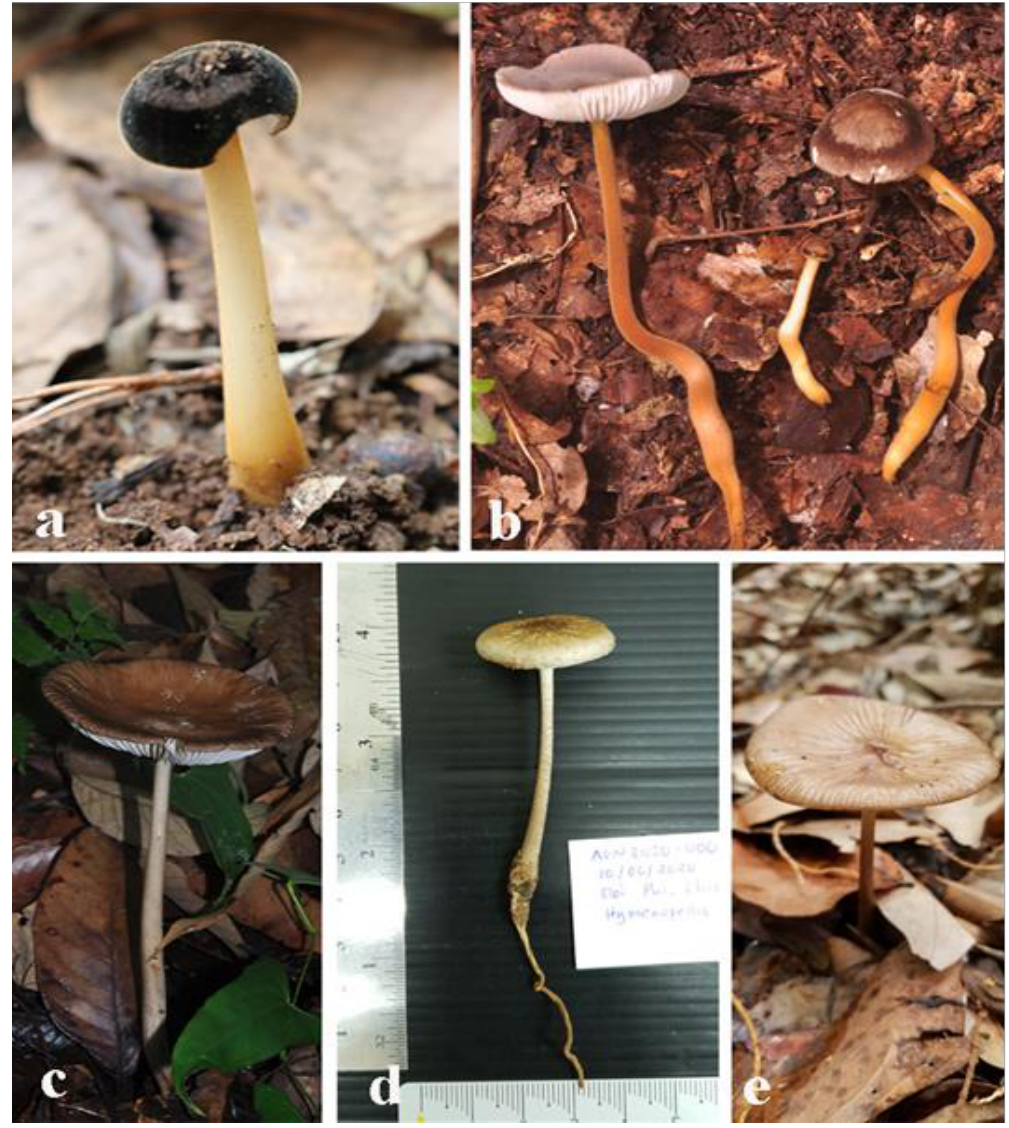
Figure 2. Some basidiomata collected from the wild in Thailand. ( a ). Xerula sp. (immature basidioma) ( b ). Xerula sinopudens ( c – e ). Hymenopellis sp. Photos by A.G. Niego.